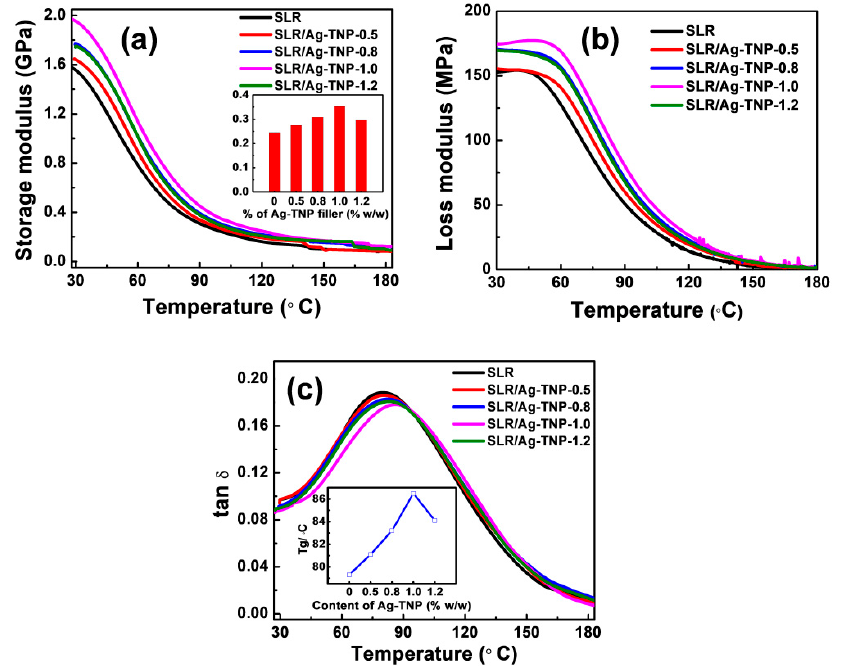
Figure 9. Thermo-mechanical analyses of neat SLR and SLR / Ag-TNP nanocomposites ( a ) comparative storage modulus, ( b ) comparative loss modulus curves, and ( c ) comparative tan δ curves. The inserts in ( a ) and ( c ) express the dissimilarity of tan δ and storage modulus of SLR / Ag-TNP nanocomposites with di ff erent loadings of Ag-TNP in the photo resin, respectively.